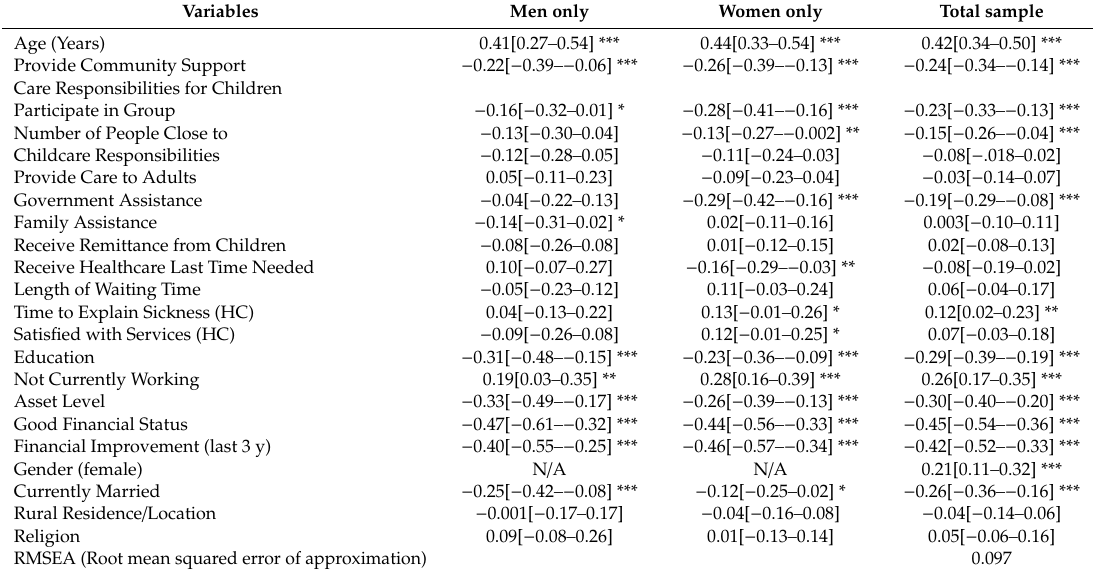
Table 2. Determinants of subjective wellbeing sorted by